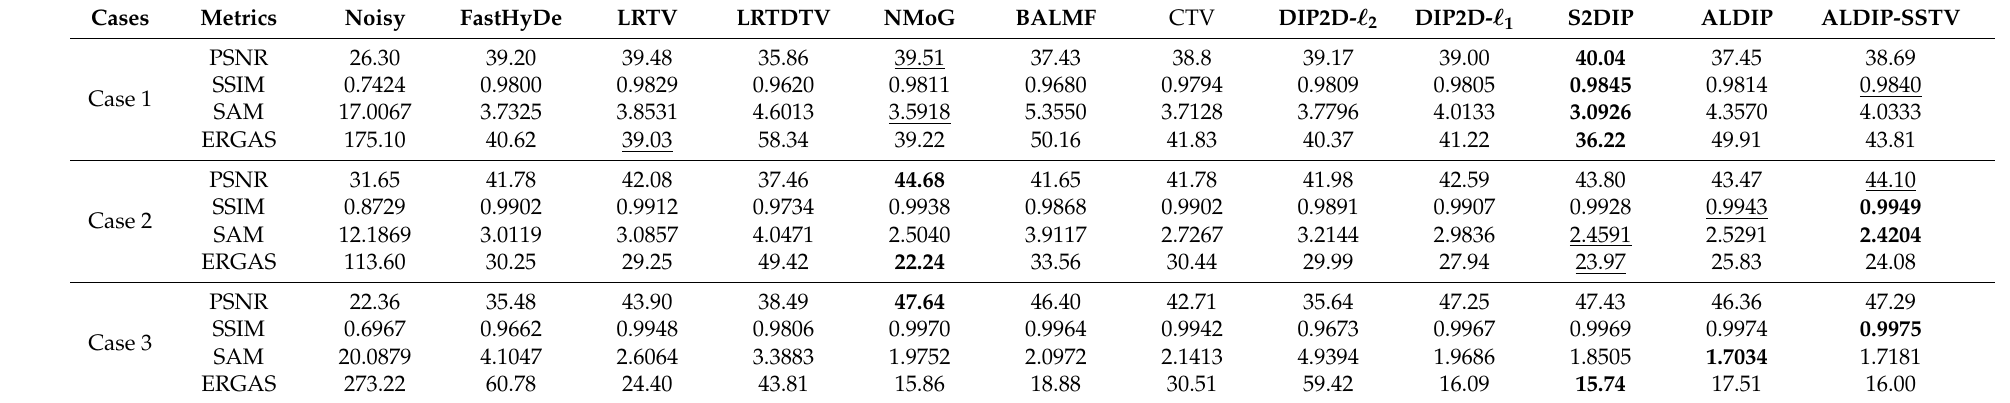
Table 3. The metrics of a synthetic data experiment on the HSI dataset Pavia Centre. The optimal values are indicated in bold and the second-best values are